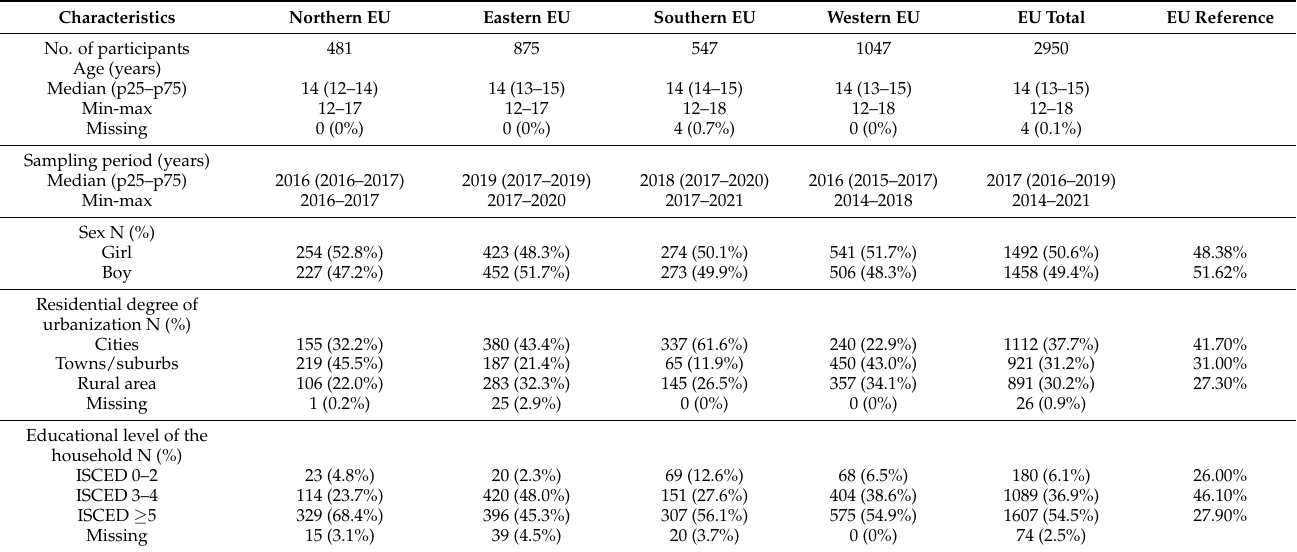
Table 3. Characteristics of sampled population teenagers by European region and in total.